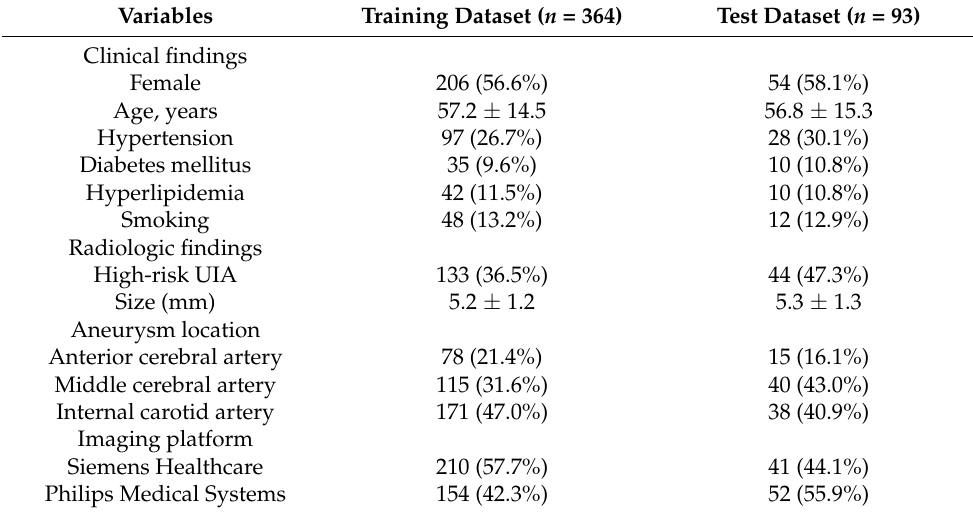
Table 1. Clinical and radiological characteristics: training vs. test